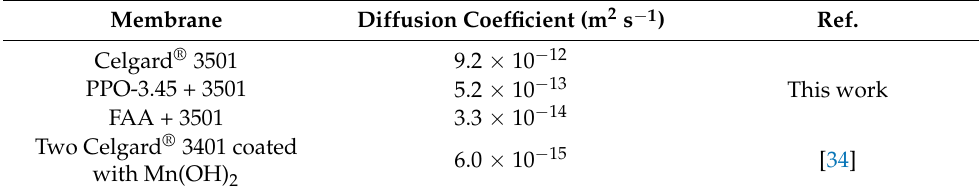
Table 5. Zincate ions diffusion coefficient through the modified membranes.